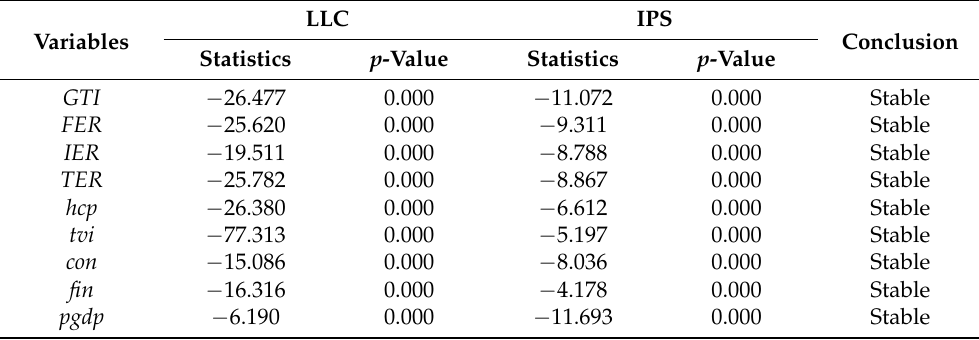
Table 3. Panel unit root test